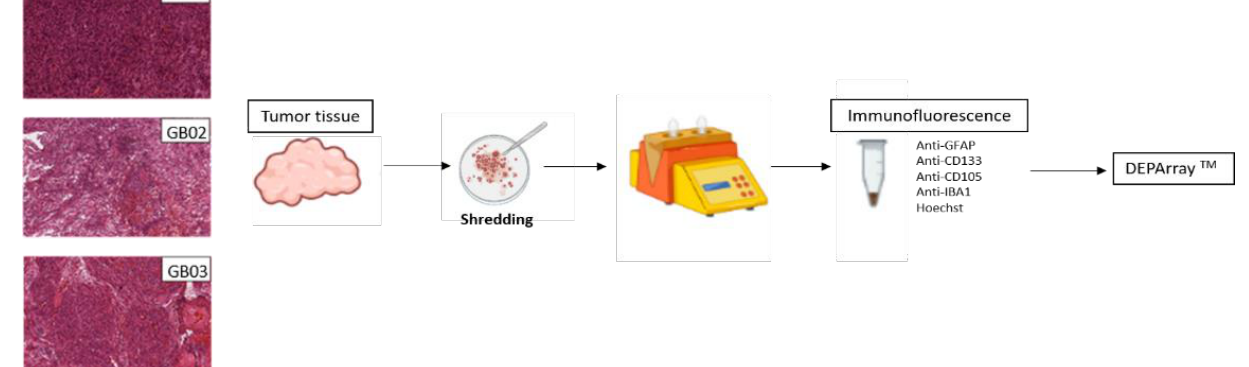
Figure 1. Histological images of GB01, GB02, and GB03. Experimental design starting from tumor shredding to DEPArray analysis.